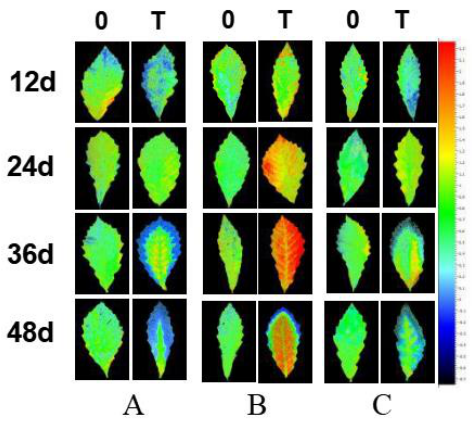
Figure 7. Changes in the non-photochemical quenching (NPQ) in ectomycorrhizal seedlings of Q. mongolica under NaCl stress (0: 0 mM; T: 120 mM; ( A ) control group; ( B ) G. viscidus group; ( C ) S. luteus group).